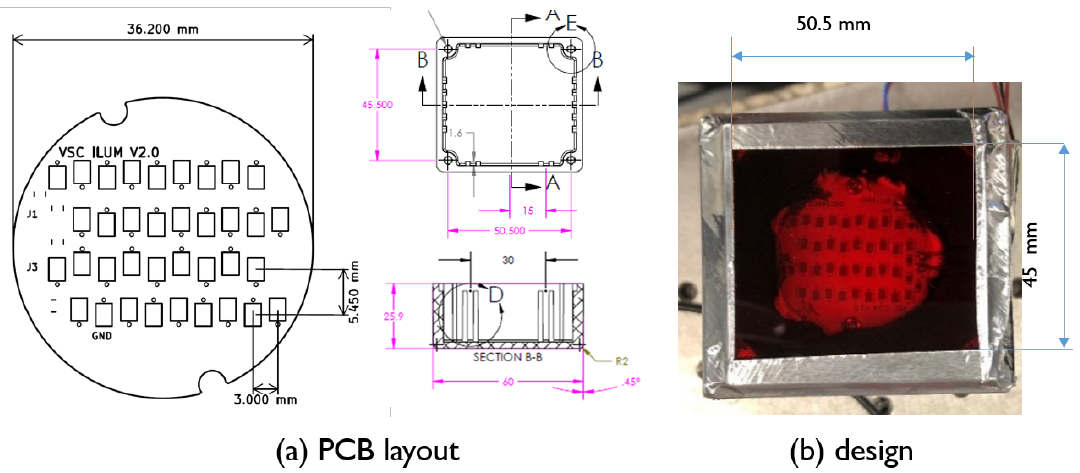
Figure 6. Details of the constructed illumination unit: ( a ) PCB drawing; and ( b ) final design of our built illuminator (with a visible light block filter).